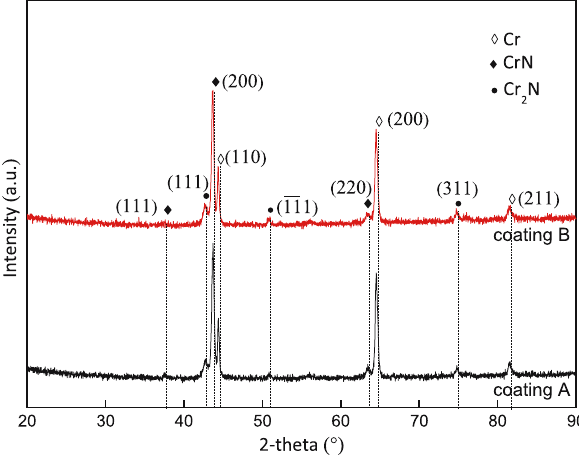
Figure 5: XRD patterns of the as - deposited